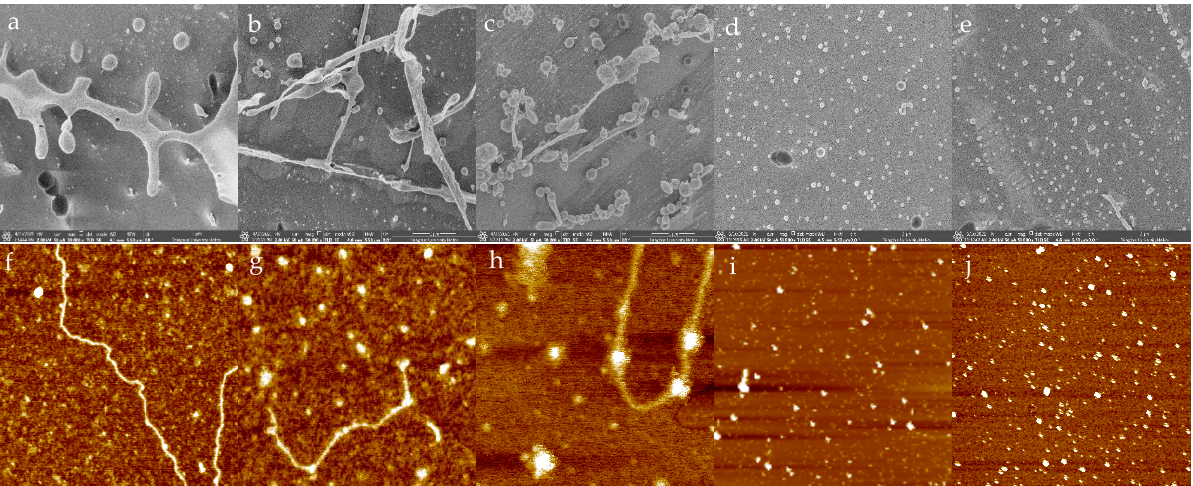
Figure 6. Cryo-SEM and AFM graphs of WSG and its conjugates: ( a ) Cryo-SEM graph of WSG; ( b ) Cryo-SEM graph of WSG-PPI conjugates; ( c ) Cryo-SEM graph of WSG-SPI conjugates; ( d ) Cryo-SEM graph of PPI; ( e ) Cryo-SEM graph of SPI; ( f ) AFM graph of WSG; ( g ) AFM graph of WSG-PPI conjugates; ( h ) AFM graph of WSG-SPI conjugates; ( i ) AFM graph of PPI; ( j ) AFM graph of SPI.